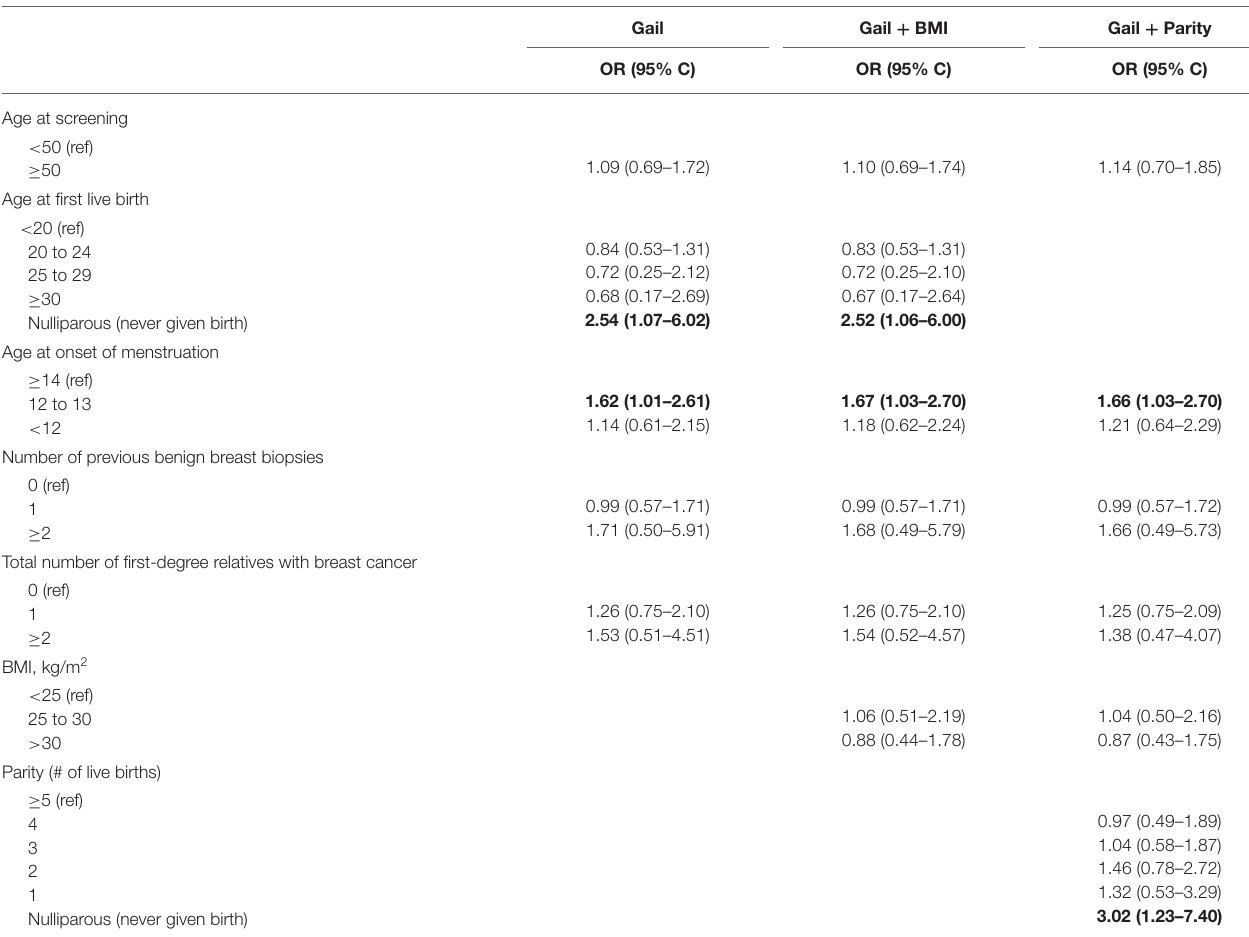
TABLE 1 | Logistic regressions using risk factors from Gail model with additions of BMI and parity.